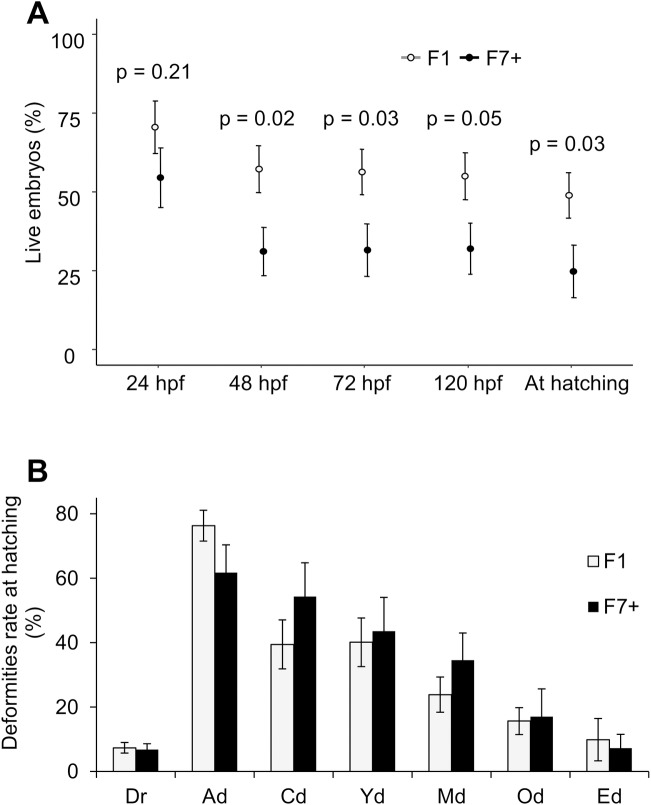
Evaluation of the embryonic developmental success in F1 and F7+ populations.(A) Percentage of embryos surviving at 24, 48, 72 and 120 hours post-fertilization (hpf) and at hatching in F1 (light gray dots) and F7+ (black dots) populations estimated based on the total number of studied embryos (about 100 embryos). In (A), dots represent population means ± SEM at each observed time (n = 19 and 13 for F1 and F7+, respectively). P-values presented represent comparisons between populations at each time of observation obtained using a TukeyHSD preceded by a significant one-way ANOVA in repeated measures (p ≤ 0.05 were considered as significant). (B) Total deformities rates (Dr) and specific rates in various tissues at hatching in F1 and F7+ populations (Ad—Axis, Cd—Cardiac, Yd—Yolk, Md—Mouth, Od–Other, Ed—Eyes). No significant difference has been identified between populations using non-parametric Wilcoxon-Mann-Whitney test (p<0.05; n = 23).